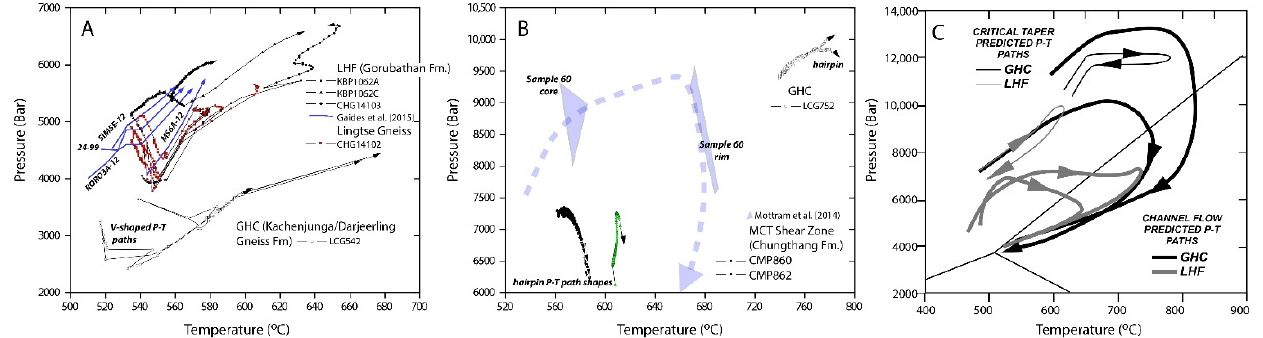
Figure 15. ( A ) Comparison of some P-T paths from this study and those in [27]. See Figure 1 for sample locations. Note the presence of some V-shaped P-T paths. ( B ) Hairpin P-T paths from MCT shear zone and GHC samples. We also include path predictions from [28]. ( C ) Predicted P-T path shapes for the GHC and LHF rocks if they experienced discrete thrusting (critical taper) or channel flow after [102].